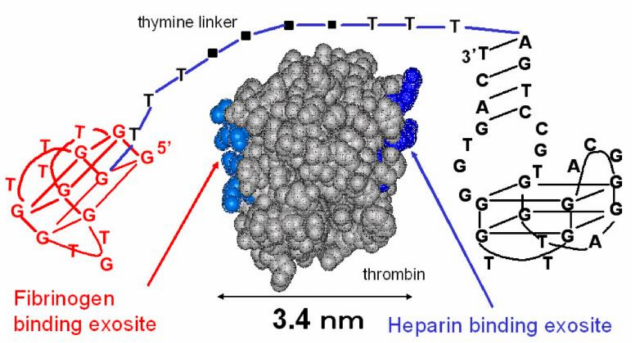
Figure 11. The structure of bivalent aptamer composed of HD1 (located at the 5 (cid:48) end) connected with HD22(29) via a poly-dT linker [61]. Reproduced under the Creative Commons Attribution